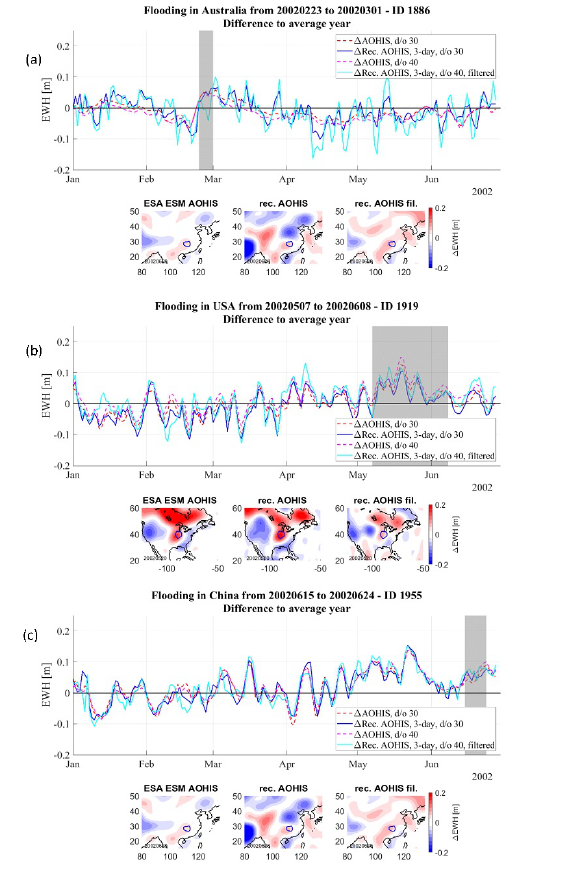
Fig. 5. Comparison between the ESA ESM AOHIS signal and the reconstructed AOHIS signal. The AOHIS signal is displayed for d/o 30 in red, and for d/o 40 in magenta, while the reconstructed AOHIS signal with d/o 30 is visualized in blue and the VADER filtered rec. AOHIS signal with d/o 40 is cyan. Below a spatial plot of the AOHIS reference signal, and the reconstructed AOHIS signal (filtered and not filtered) for d/o is